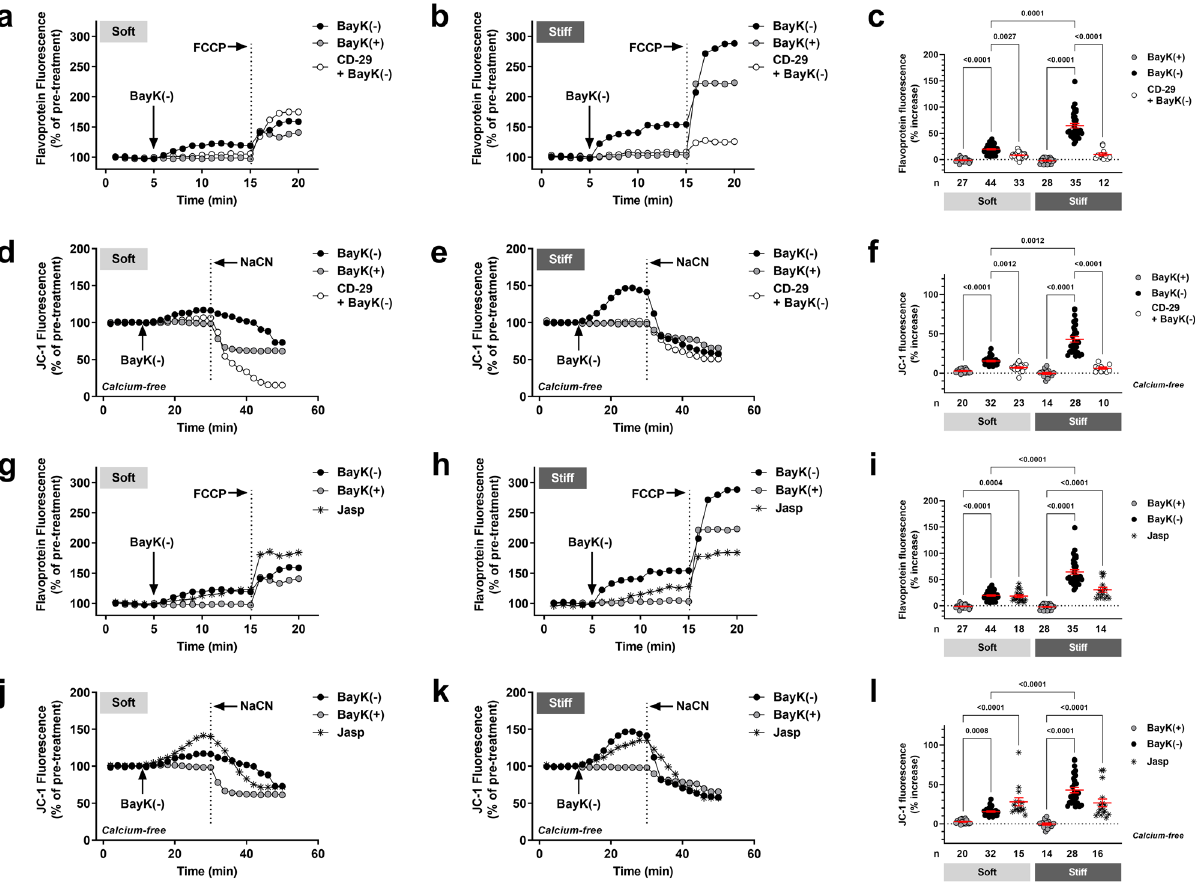
Fig. 4 The cardiac LTCC and integrin participate as partners in mediating mitochondrial function under conditions of varying substrate stiffness. Representative ratiometric fl avoprotein ( a , b and g , h ) and JC-1 ( d , e and j , k ) fl uorescence recorded from wt cardiac myocytes plated on soft and stiff hydrogels before and after exposure to 10 μ M BayK( + ), Jasplakinolide (Jasp, 1 μ M, 20 min pre-incubation), or 10 μ M BayK( − ) in the absence or presence of CD-29 (5 μ g/ml, 30 min pre-incubation). JC-1 studies were performed under calcium-free conditions (0 mM calcium). Arrows indicate addition of drugs. To con fi rm signals were mitochondrial in origin, FCCP (50 μ M) was applied at the end of each fl avoprotein experiment to increase fl avoprotein oxidation. NaCN (40 mM) was applied at the end of each JC-1 experiment to collapse Ψ m . Overall fl avoprotein ( c and i ) and JC-1 ( f and l ) fl uorescence for all myocytes ( n ) exposed to drugs as indicated, including mean ± SEM. All statistical signi fi cance determined by Kruskal-Wallis